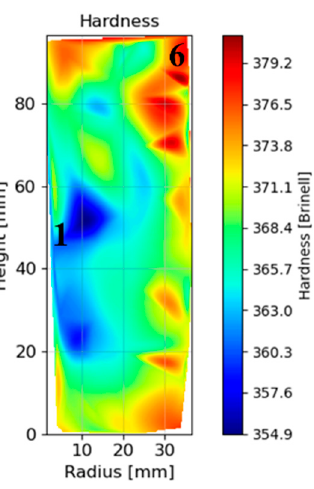
Figure 13. Hardness thermal mapping after HT-A, inner (1) and external upper (6) areas are marked.